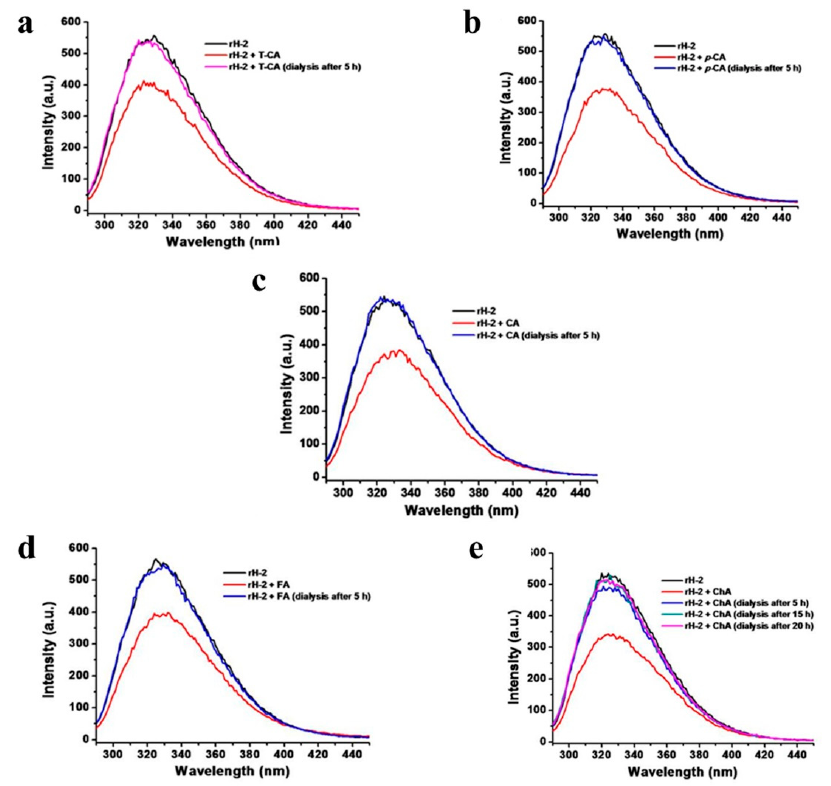
Figure. 5 Dialysis study of rH-2 with cinnamic acids at pH 7.0. a) Trans -Cinnamic acid; b) p -Coumaric Figure 5. Dialysis study of rH-2 with cinnamic acids at pH 7.0. ( a ) Trans -Cinnamic acid; ( b ) p -Coumaric acid; ( c ) Caffeic acid; ( d ) Ferulic acid; ( e ) chlorogenic acid. Conditions: 0.55 µ M rH-2 in 50 mM Tris-HCl, [cinnamic acids] = 22 µ M, 25 ◦ C. λ Ex = 280 nm, slits for excitation and emission are 5 nm and 10 acid; c) Caffeic acid; d) Ferulic acid; e) chlorogenic acid. Conditions: 0.55 μM rH-2 in 50 mM Tris-HCl, [cinnamic acids] = 22 μM, 25 ° C. λ Ex =280 nm, slits for excitation and emission are 5 nm and 10 nm